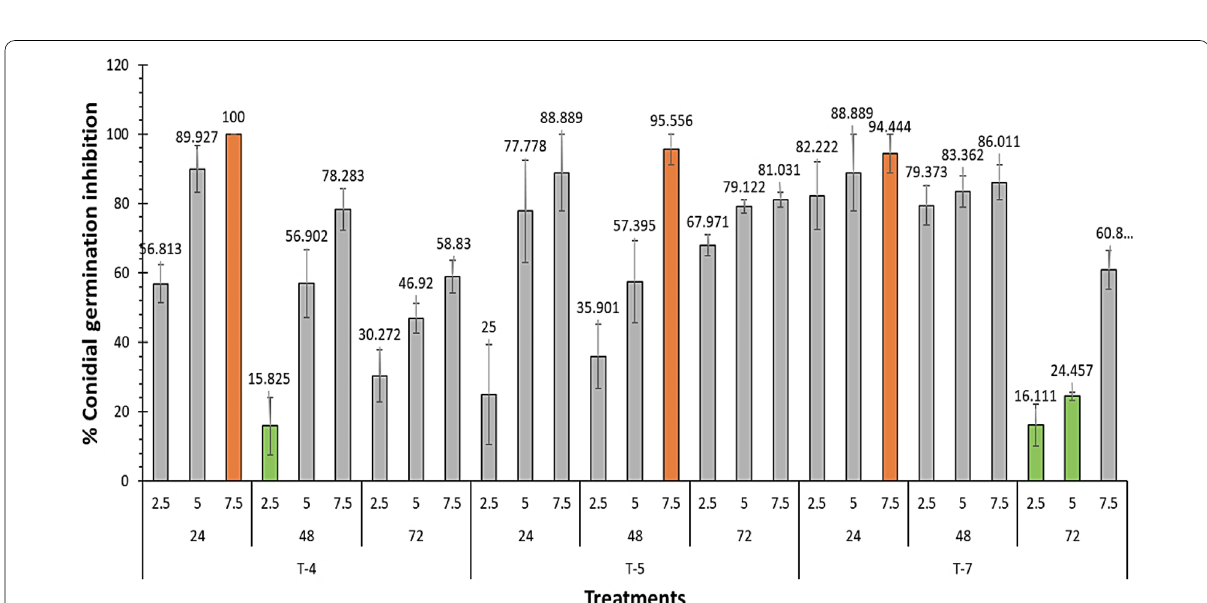
Fig. 2 Inhibition of conidial germination of F. oxysporum with different concentrations of the crude extract of A. flavus (T-7), A. fumigatus (T-5), and A. nidulans (T-4) after 24, 48 and 72